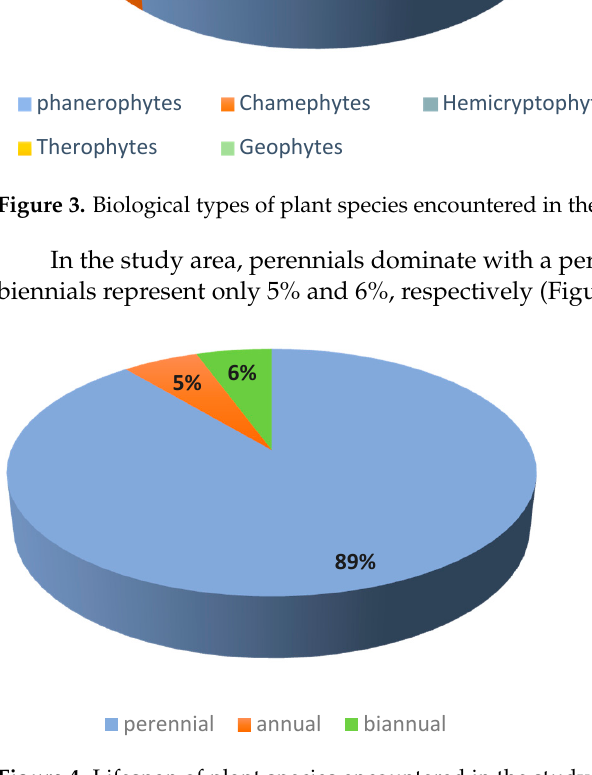
Figure 4. Lifespan of plant species encountered in the study area.